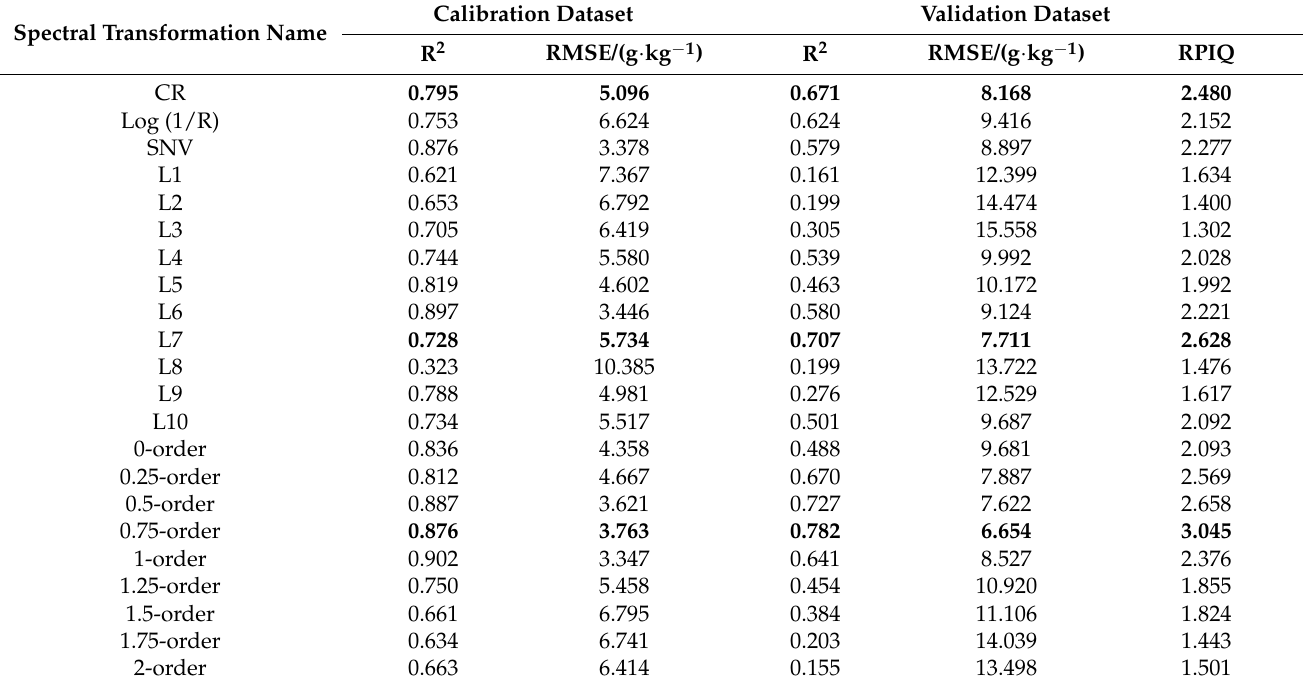
Table 5. The results of the BPNN estimation of soil iron oxide content using the full